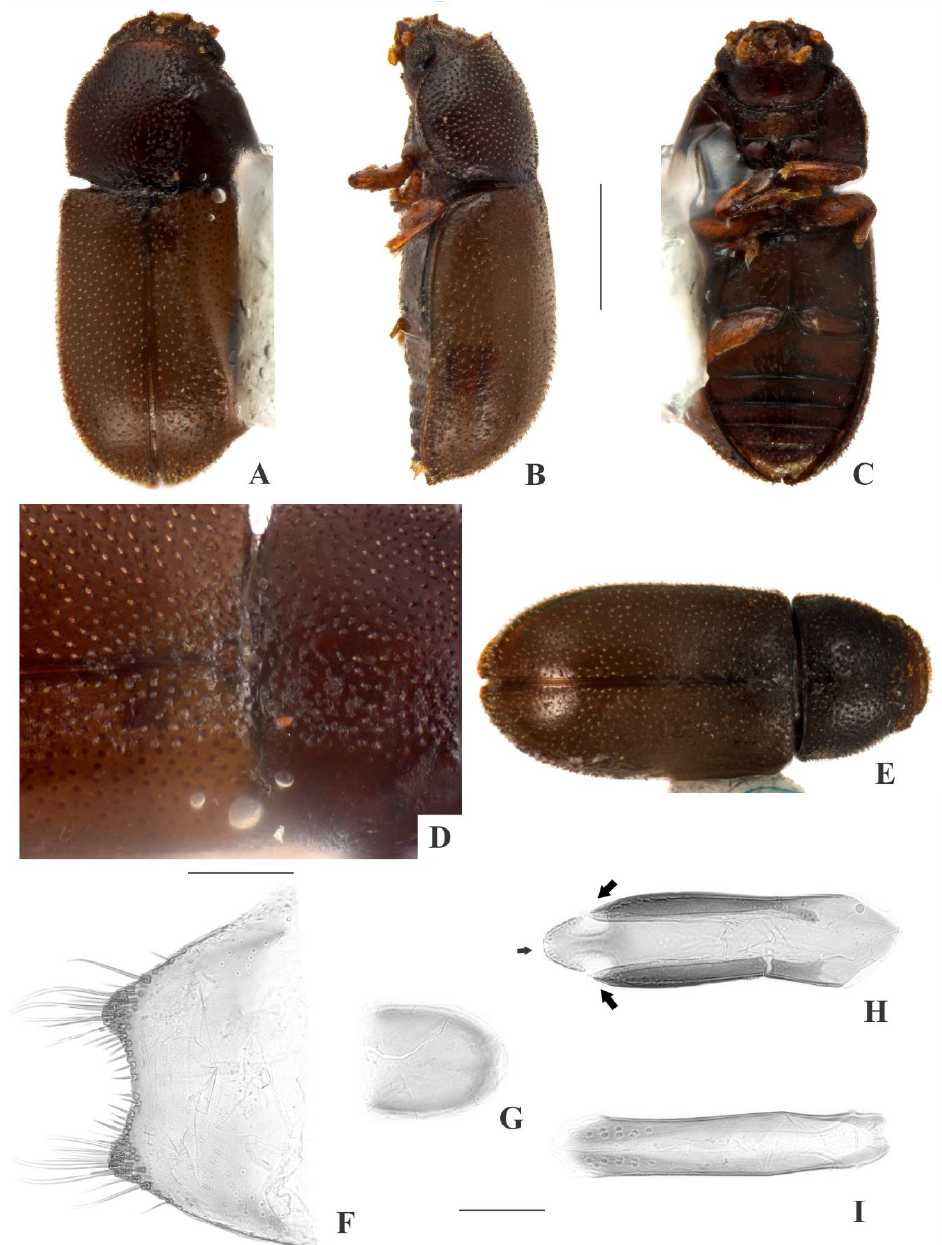
Figure 2. Cis foveocephalus sp. n. , male holotype ( A – D ), female paratype ( E ), aedeagus of paratype from type locality (F–I): A. Dorsal view. B. Lateral view. C. Ventral view. D. Scutellar shield and part of the pronotum and elytra. F. Sternite VIII. G. Basal piece. H. Tegmen, note acute lobes (big black arrows) and arrow-shaped lobe (small black arrow) at apex. I. Penis. Scale bars: 0.5 mm ( A – C , E ), 0.2 mm ( D ), 0.05 mm ( F – I ).